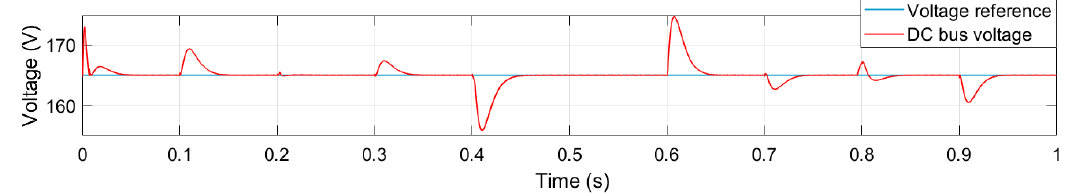
Figure 12. DC bus voltage.